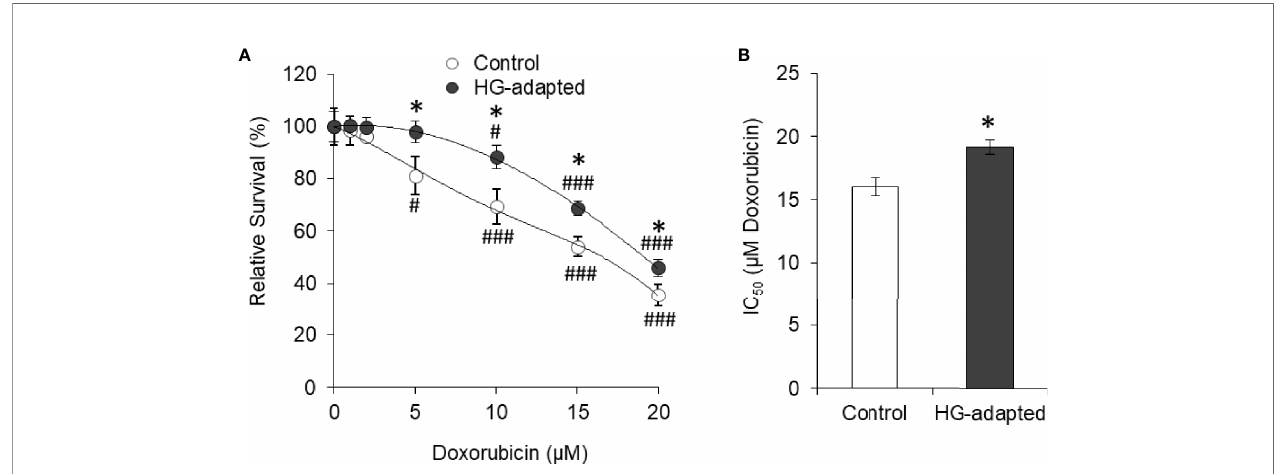
FIGURE 3 | HG-adapted cells show chemoresistance. HepG2 cells were adapted in HG medium for six frequent passages (every 3 days). Cell survival of control and HG-adapted cells was estimated after incubation in medium containing increasing concentration of doxorubicin (A) . IC 50 of doxorubicin was estimated for both the cells (B) . The values shown are Mean ± SD of three independent experiments conducted in triplicate. * p < 0.05 vs values of cells of control group. # p < 0.05, ### p < 0.001 vs values of cells incubated in medium without doxorubicin.